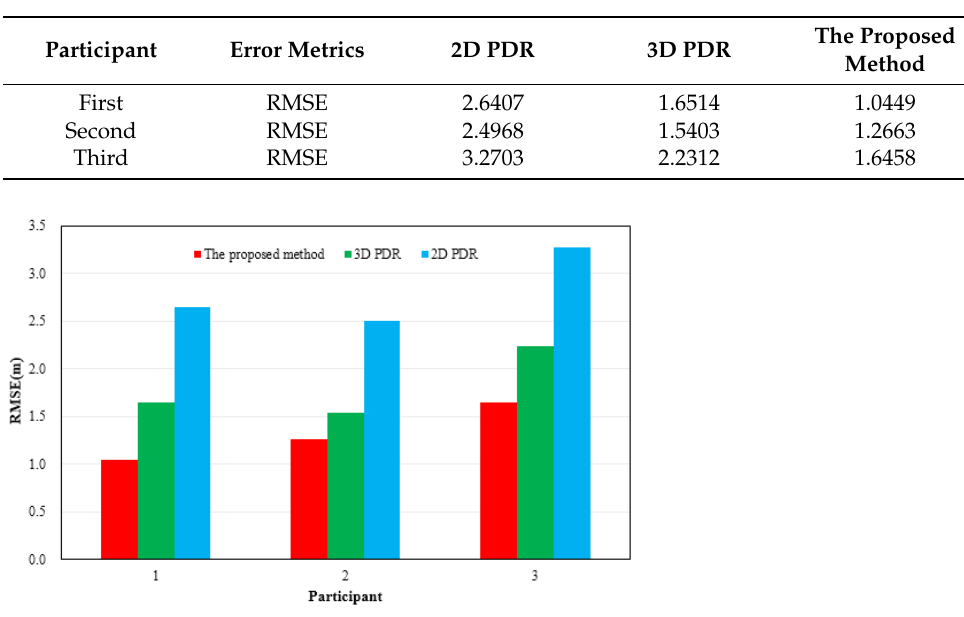
Figure 6. Distributions of location errors with respect to three participants, ( a , b ) participant 1, ( c , d ) participant 2, and ( e , f ) participant 3. Table 3. Statistical results of the RMSE of location results (m). Table 3. Statistical results of the RMSE of location results (m).